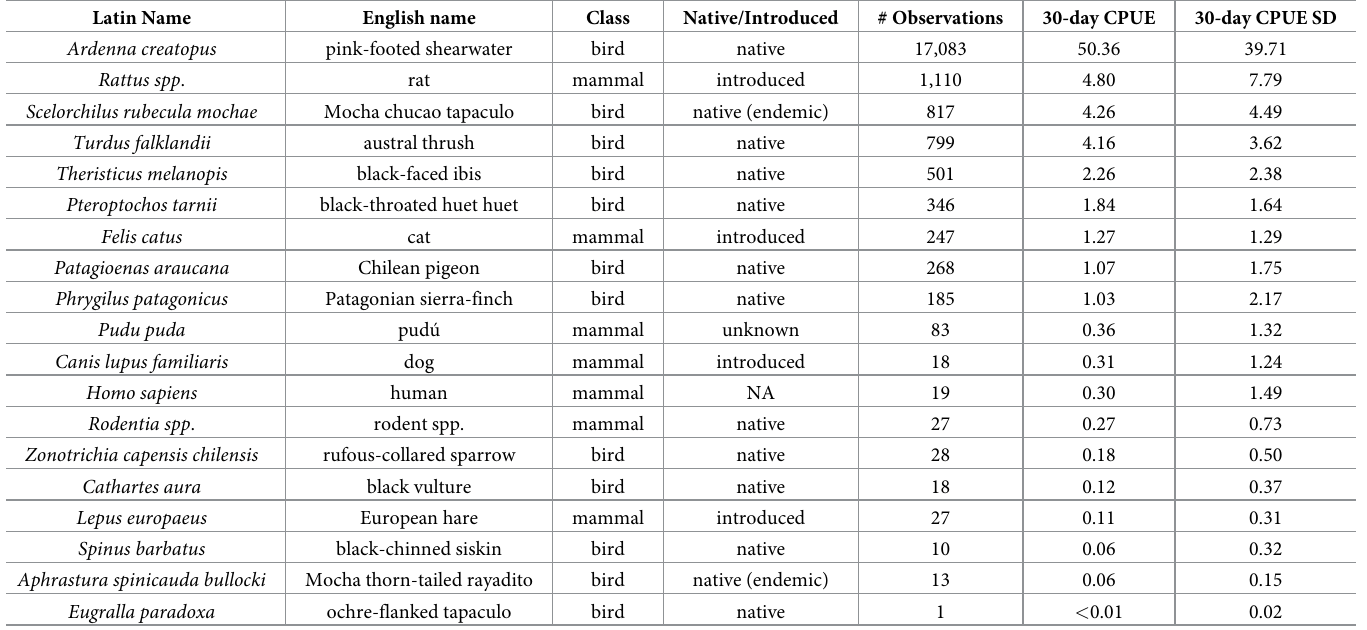
Table 1. Detections of animals from trail cameras at five pink-footed shearwater colonies on Isla Mocha, Chile, during 2015–2020. Latin